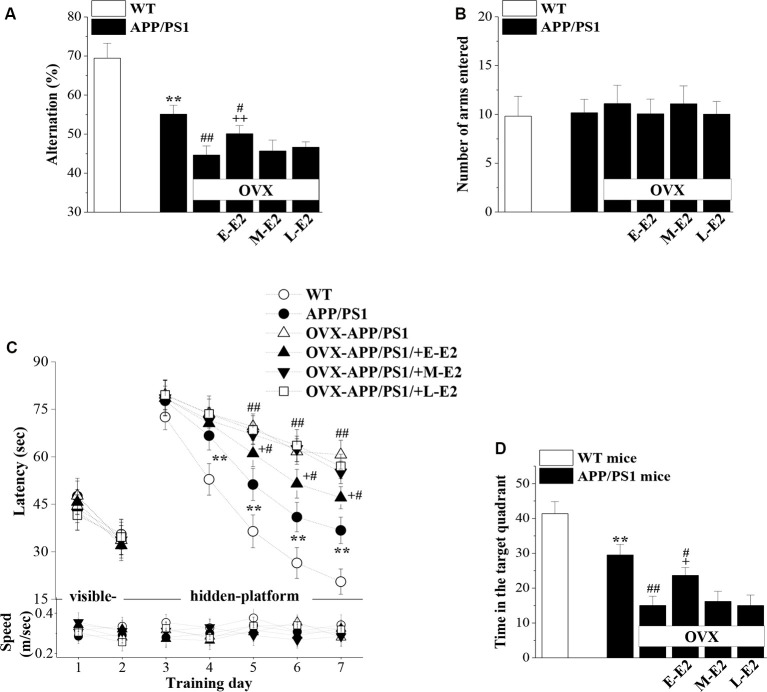
The administration of E2 in the early period post-OVX alleviates the cognitive deficits in aged APP/PS1 mice. (A,B) Influence of E2 treatment in the early period (E-E2), mid period (M-E2), or late period (L-E2) on working memory as assessed by the Y-maze test in 10-month-old APP/PS1 mice. The bar graphs show the spontaneous alternation ratio (%) and the total number of arm entries in the Y-maze test of APP/PS1 mice. **P < 0.01 vs. WT mice; #P < 0.05 and ##P < 0.01 vs. sham-op APP/PS1 mice; ++P < 0.01 vs. OVX-APP/PS1 mice (two-way ANOVA). (C) Spatial learning and memory were assessed by the Morris water maze (MWM). Each point represents the mean latency (sec) to reach the platforms (upper panel) and the swimming speeds (m/s; bottom panel). **P < 0.01 vs. WT mice; #P < 0.05 and ##P < 0.01 vs. sham-op APP/PS1 mice; +P < 0.05 vs. OVX-APP/PS1 mice (repeated measure ANOVA). (D) Probe trial test. The bars represent the percentages of swimming time spent in the platform quadrant. **P < 0.01 vs. WT mice; #P < 0.05 and ##P < 0.01 vs. sham-op APP/PS1 mice; +P < 0.05 vs. OVX-APP/PS1 mice (two-way ANOVA).